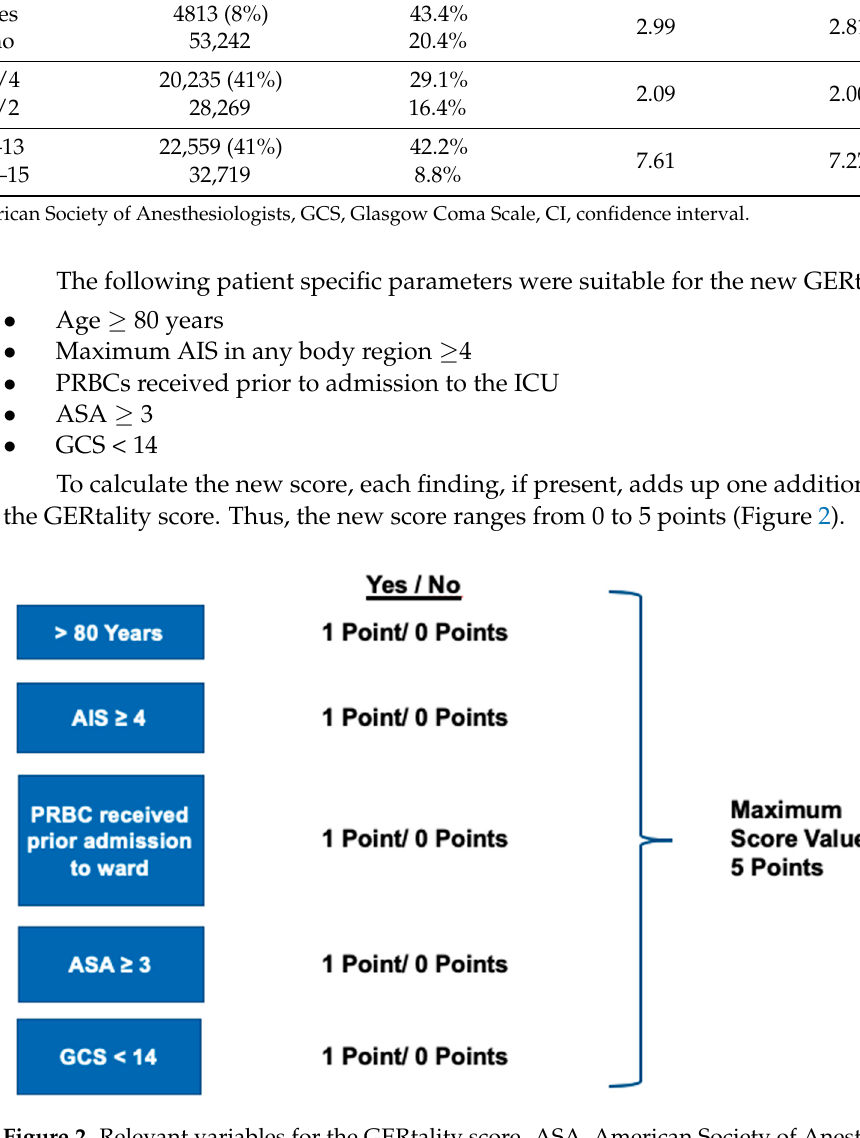
Figure 3. Observed in-hospital mortality rate based on GERtality score calculation. GERtality score comparison: The final ROC analysis of our patient collective showed an AUC (area under the curve) for the new GERtality score of 0.803 (CI (confidence interval) 0.799–0.807). The complex RISC-II score with its 15 variables showed an AUC of 0.879 (CI 0.876–0.883),